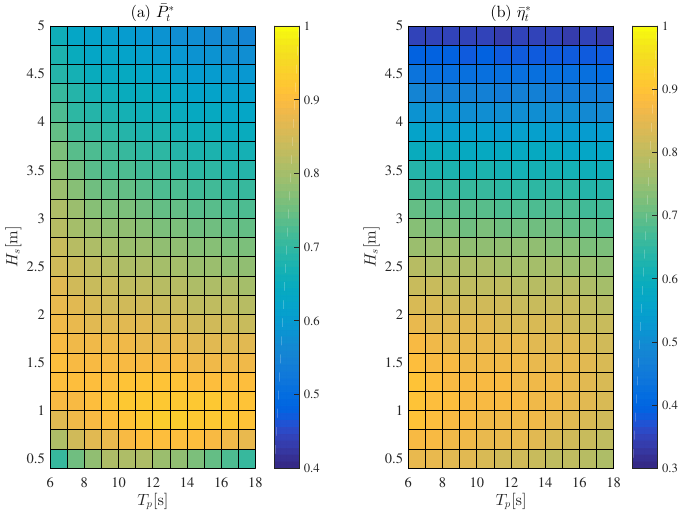
Figure 14. Time averaged results of the CAV controller under the PM irregular wave model with various T p and H s for T m = 5000 s when Ω d = 250 rad/s: ( a ) relative power extraction from turbine; ( b ) relative average turbine